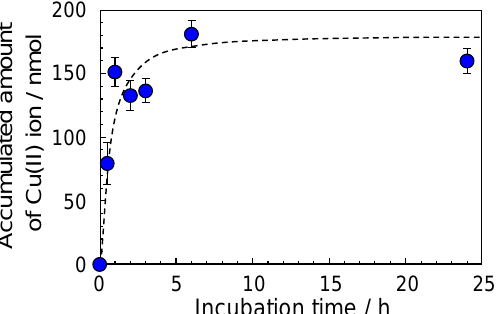
Figure 4. Accumulated amount of Cu(II) ion by the F-20 wt% SiNSi composite material at various times. The concentration of the Cu(II) ion was 50 ppm. The concentration of the Cu(II) ion was estimated from a calibration curve with the metal indicator. Each of the values represents the mean of three separate determinations ± standard deviations.